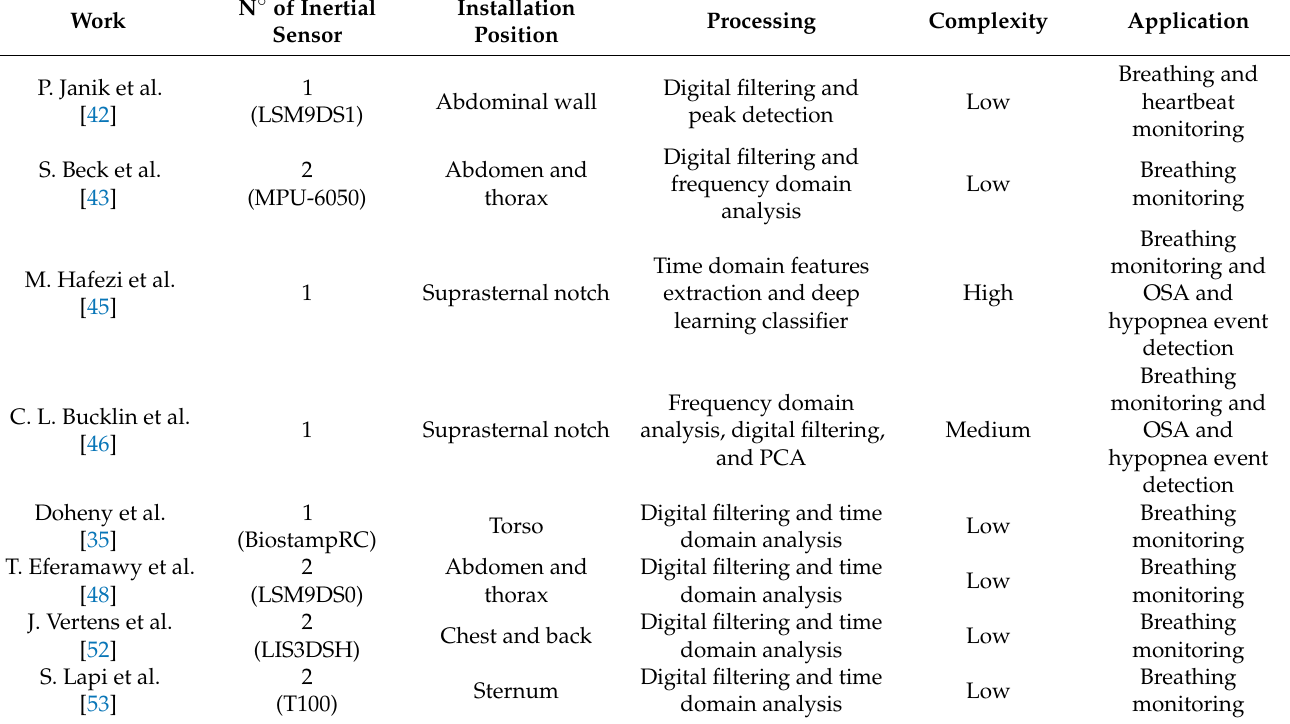
Table 1. Comparative table between the scientific work previously